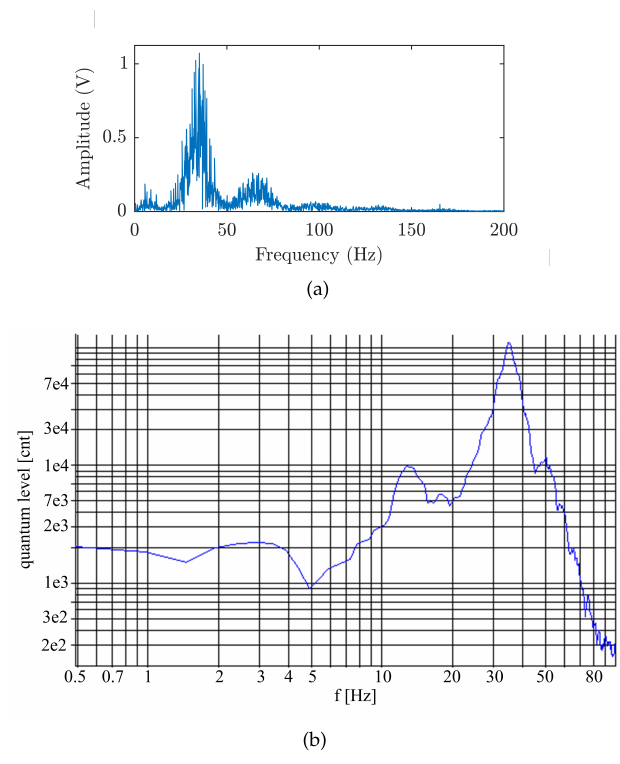
Figure 12. ( a ) Frequency spectrum of the passing tram measured by the interferometric sensor; ( b ) frequency spectrum (original report) measured by the seismic